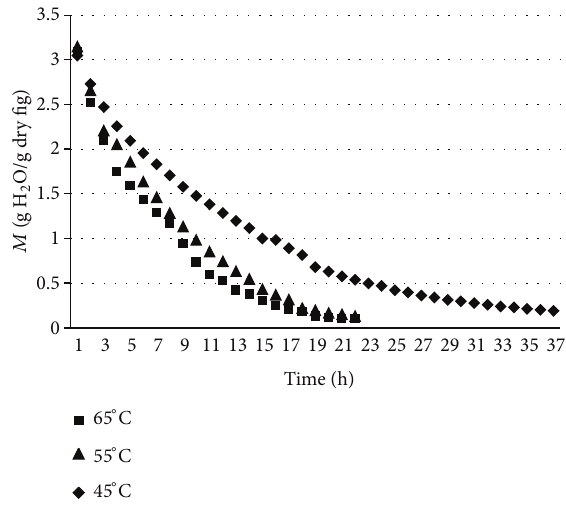
Figure 3: Effect of different temperatures in drying of half-cut figs (final moisture contents 14.3 ± 4.2 , 10.7 ± 4.7 , and 6.3 ± 2.8 at 45 ∘ , 55 ∘ , and 65 ∘ C,